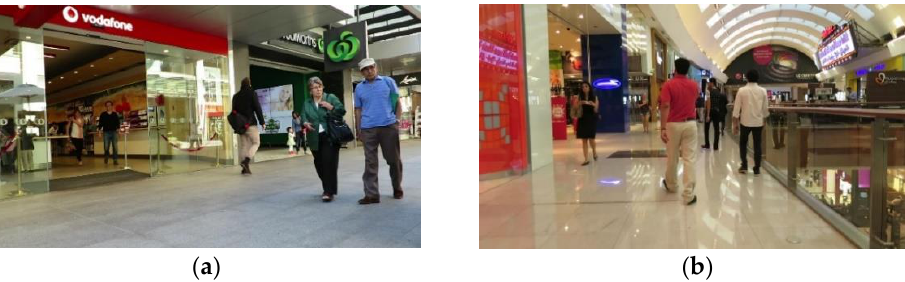
Figure 6. Samples from the MOT17Det dataset [48–50]. ( a ) Sample from MOT17-09 that contains images taken from outside a shop alley. ( b ) Sample from MOT17-11 which contains images taken from inside a shopping mall.